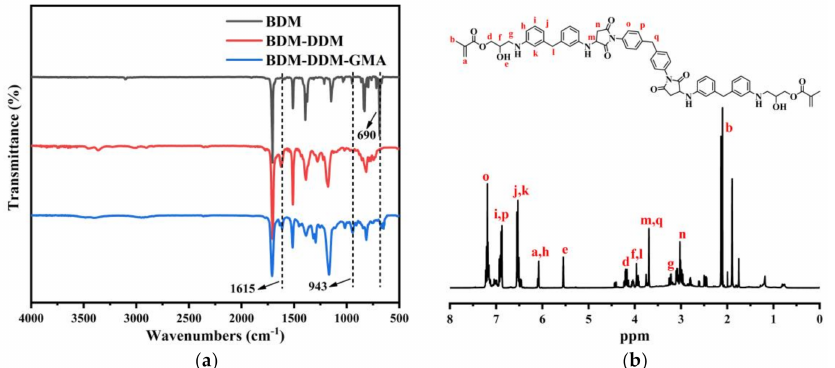
Figure 1. ( a ) Fourier transform infrared (FT-IR) spectra of BDM, BDM-DDM, and BDM-DDM-GMA. ( b ) 1 H nuclear magnetic resonance (NMR) spectrum of BDM-DDM-GMA. 1 H NMR spectroscopy was employed to characterize the BDM oligomer. As shown